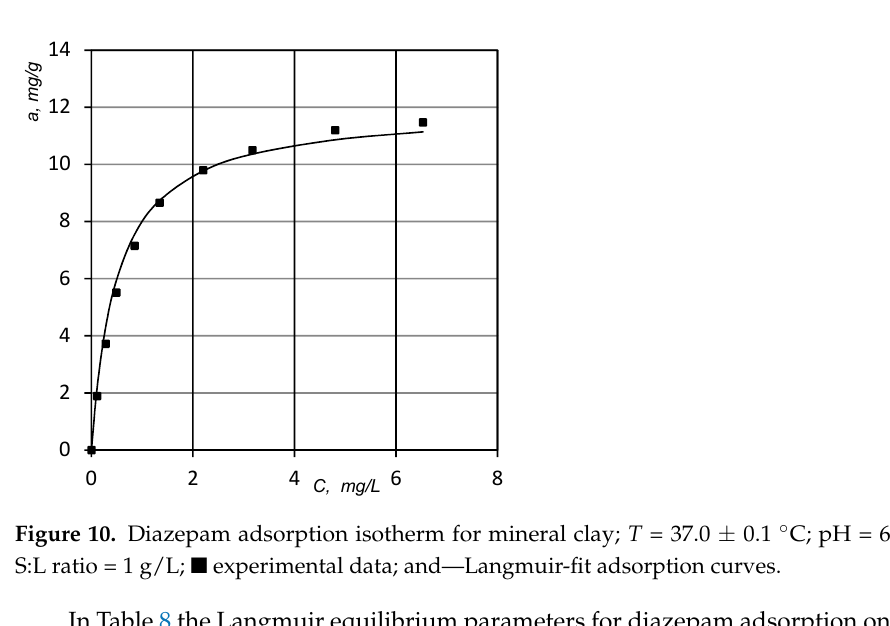
± 0.1 °C; Ph = 6.80 ± 0.05;